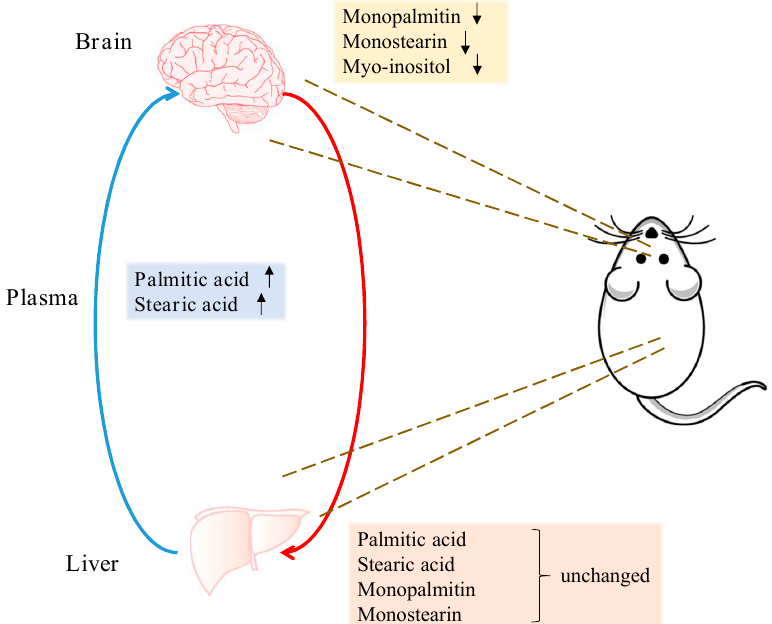
Figure 5. Summary of region-specific metabolite changes. Arrows indicate metabolites significantly increased or decreased in the midbrain and plasma of the 6-OHDA-treated animals. Levels of these metabolites remained unchanged in the liver.